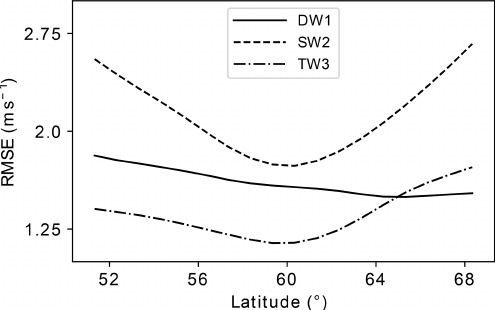
Figure 7. Yearly RMSE between the tidal fields constructed from fits to 2014 NAVGEM-SD and NAVGEM-360 taken along each lat- itude between 52 and 68 ◦